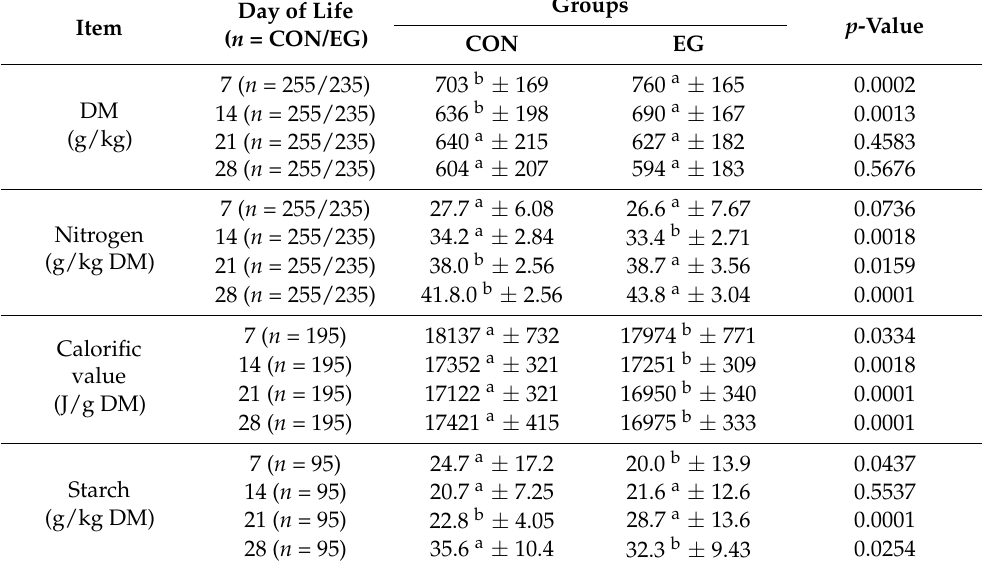
Table 4. Dry matter (DM) (g/kg), nitrogen (g/kg), calorific value (J/g) and starch (g/kg) of litter from d 7 to d 28. Nitrogen, calorific value and starch are expressed on dry matter basis (mean ± SD). Day of Item